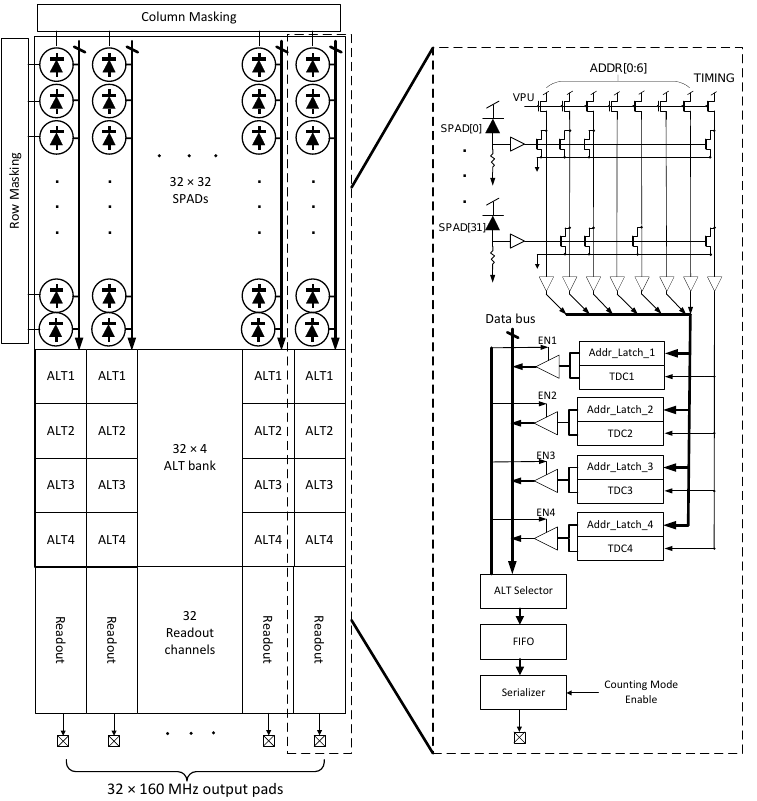
Figure 1. Image sensor architecture.